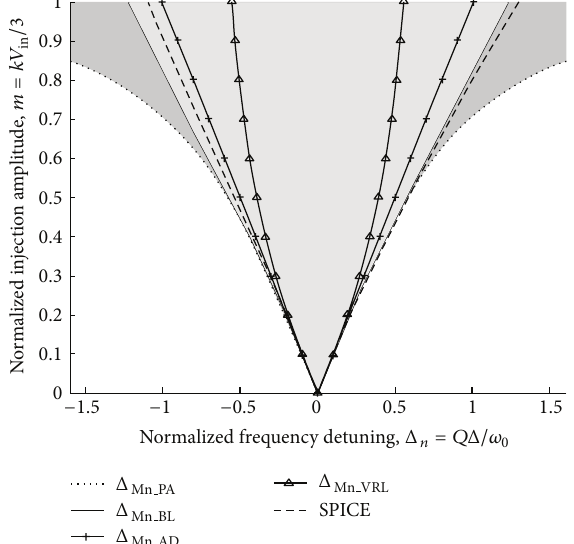
Figure 2: Comparison of the boundaries of the locking range (Arnold’s tongue) for a frequency divider with saturation-like nonlinearity, obtained by formulas and by numerical simulations. Δ Δ Δ Δ 𝑀 PA is shown in (10), 𝑀 BL in (22), 𝑀 AD in (9), and 𝑀 𝑉𝑅𝐿 in (12). Numerical simulations are obtained by using the following parameters of the circuit in Figure 1: 𝐿 = 4 nH, 𝑅 = 400 , 𝜔 0 = = 2 mA, and 𝑘 = 2.6/𝑉 1.8 GHz, 𝐼 0